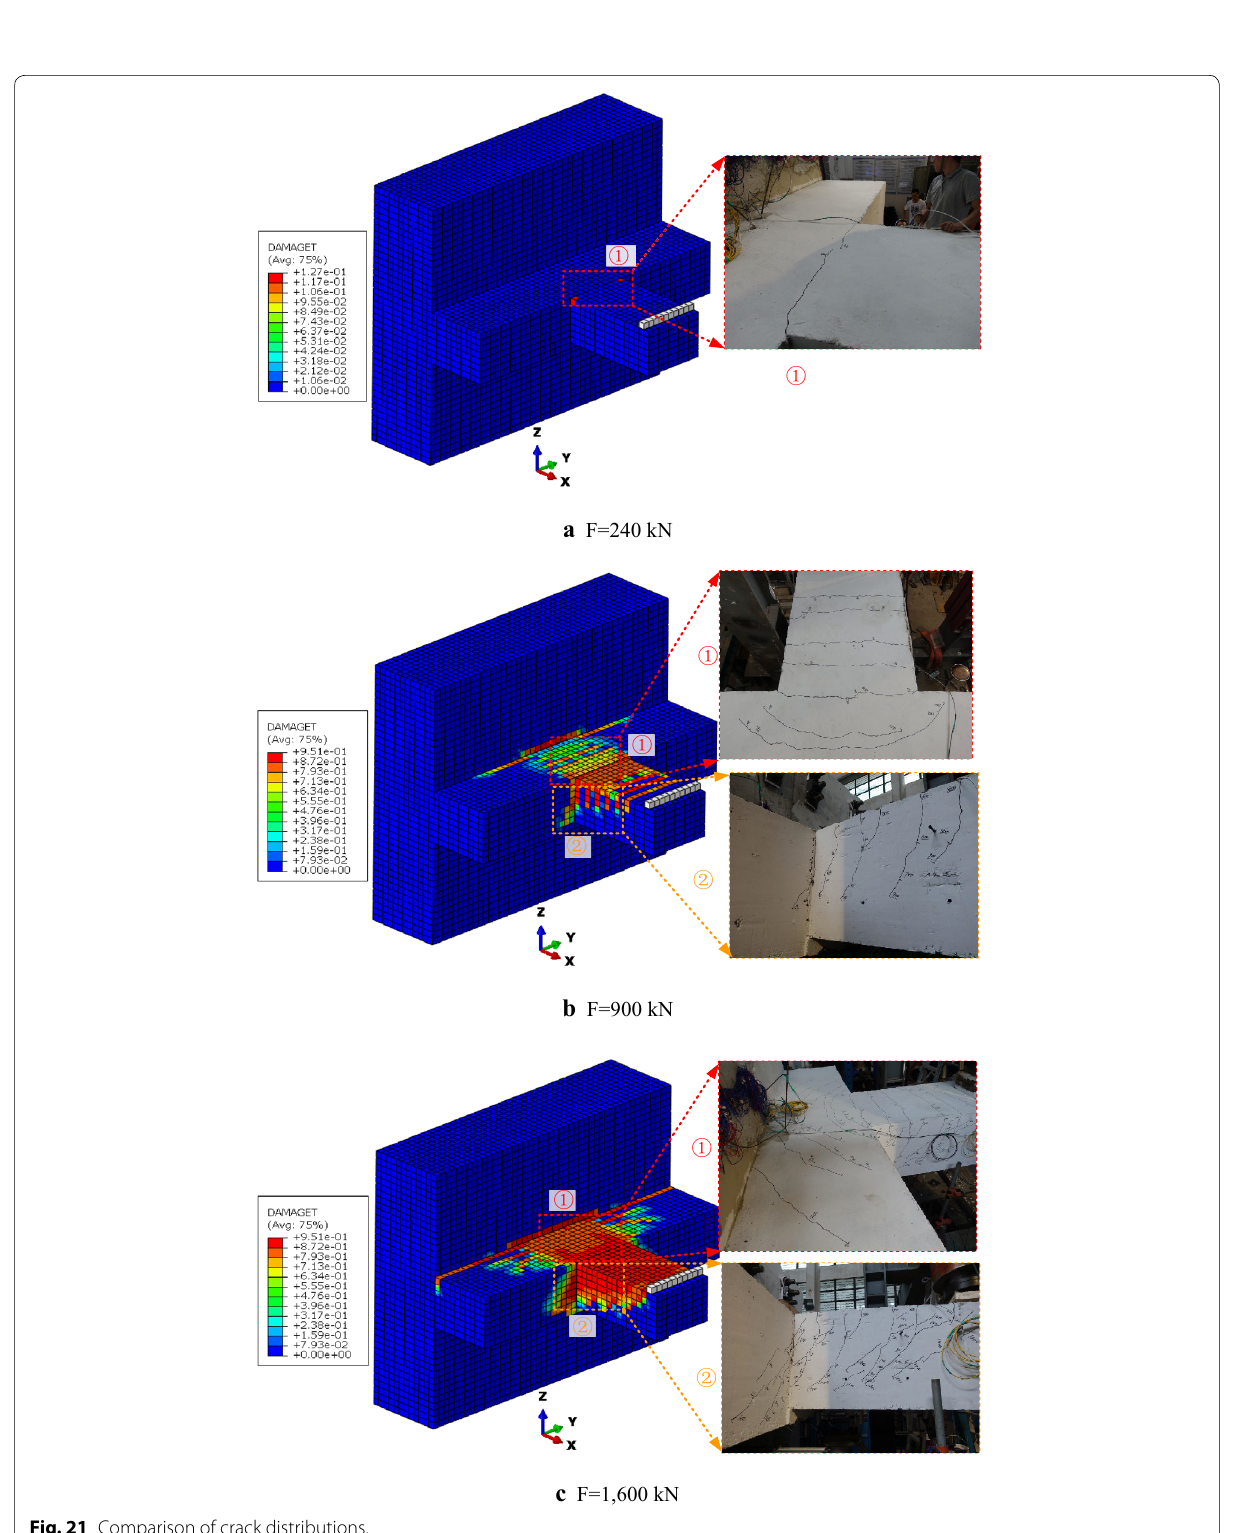
Fig. 21 Comparison of crack